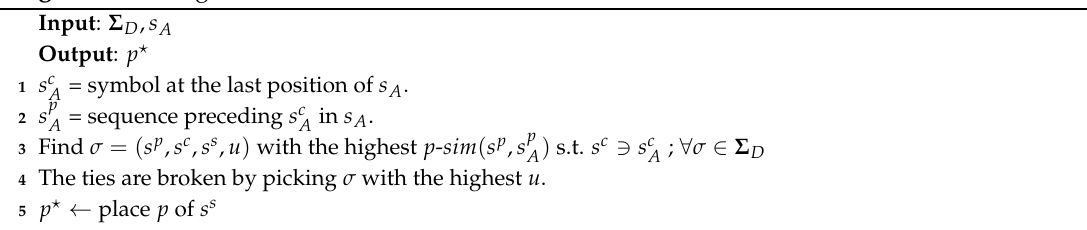
Algorithm 4: Algorithm for Next Location